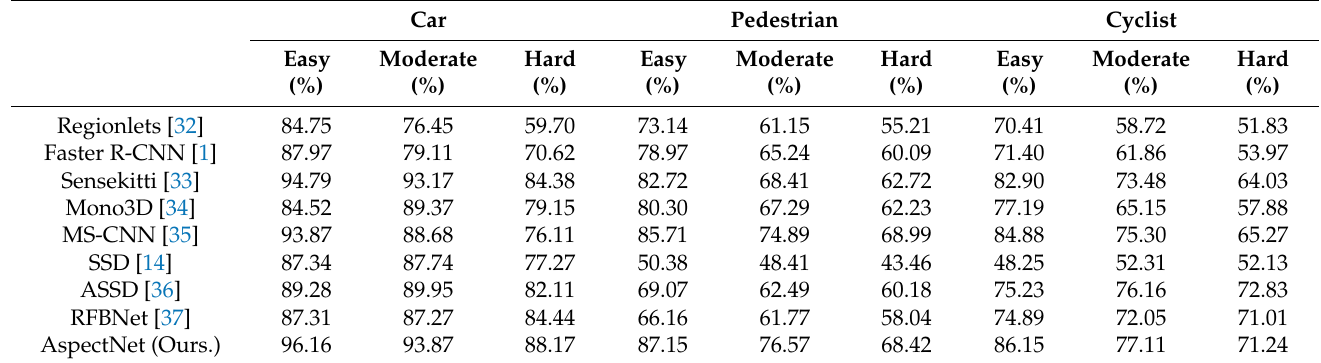
Table 6. Comparison results for detection methods on the KITTI val dataset.